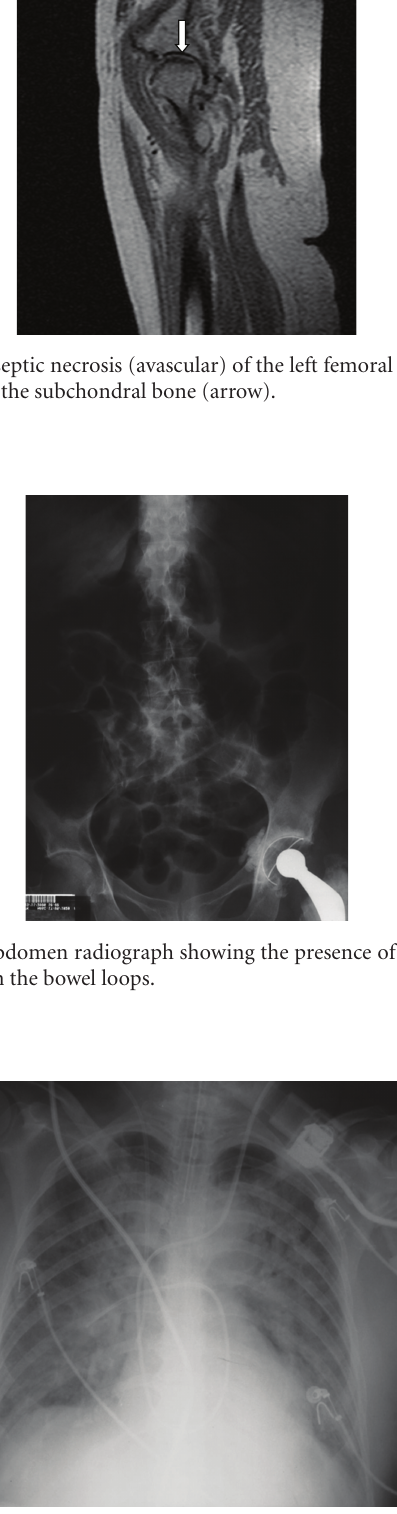
Figure 3: Chest radiograph showing bilateral pulmonary parenchy- mal infiltrate compatible with